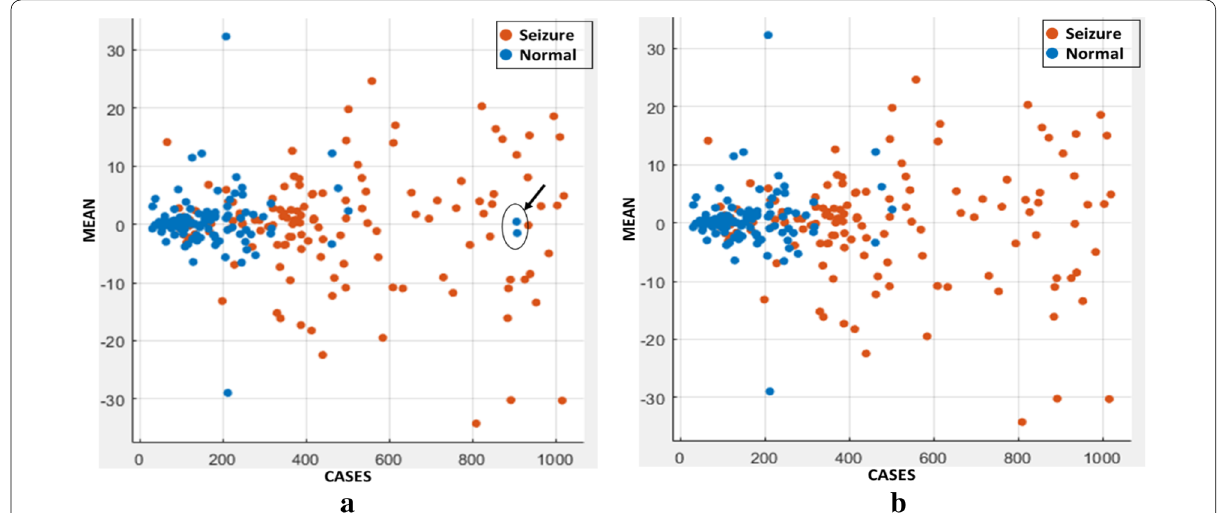
Fig. 2 Dataset distribution a dataset with abnormal points, b dataset without abnormal